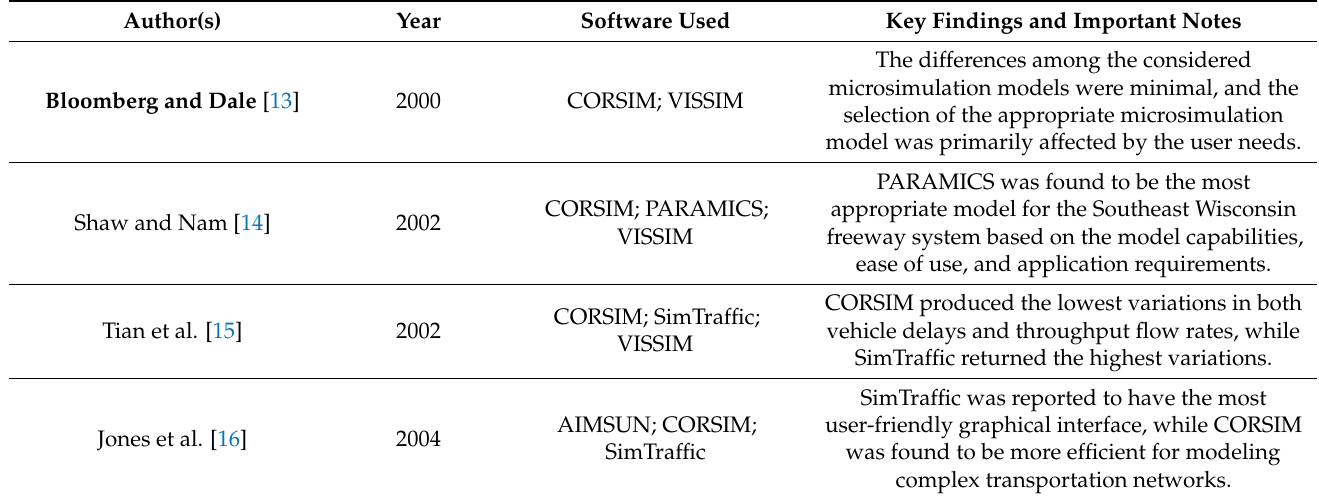
Table 1. Literature review